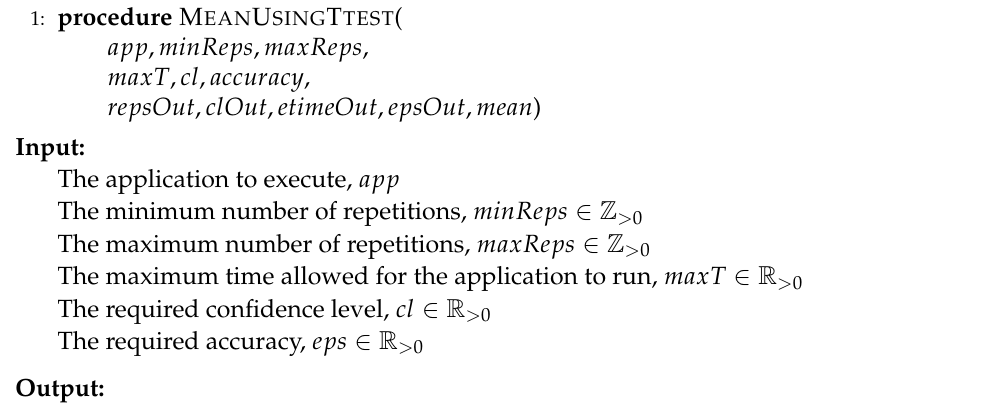
Algorithm 1 Function determining the sample mean using Student’s t